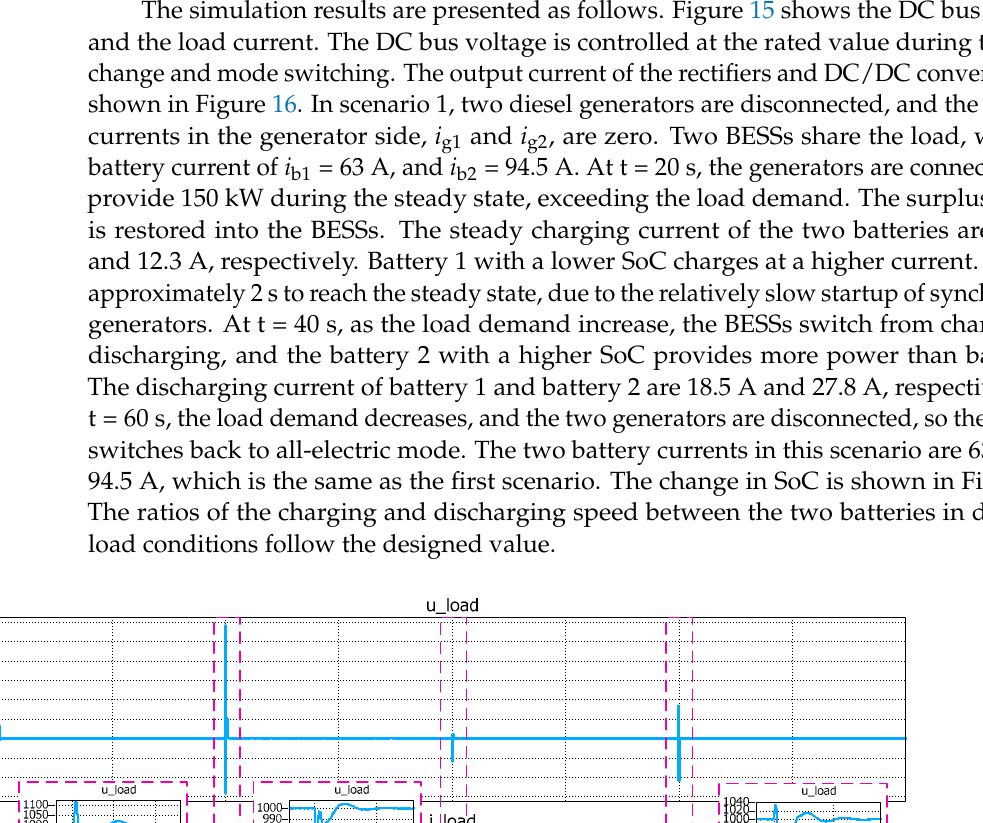
Figure 14. S oC of battery 1 and battery 2 in hybrid electric mode. Figure 14. SoC of battery 1 and battery 2 in hybrid electric mode.